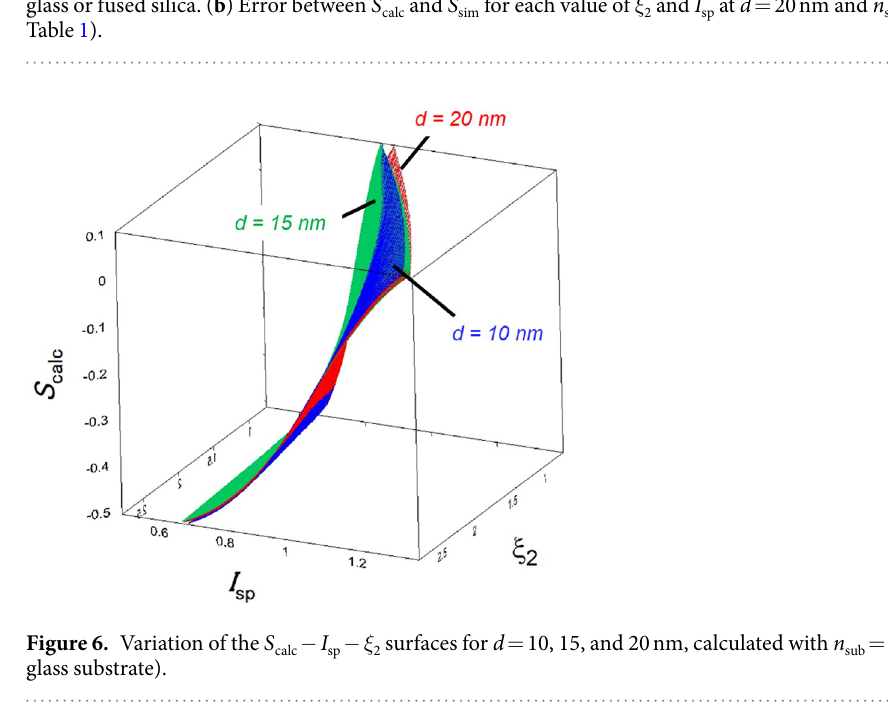
(DACT-II):CBP. Table 2 summarizes the S calc and reported S values. Even for the largest error, the differences between the calculated and simulated values were less than 0.05, and in good agreement with our estimation (Fig. 5b). While the dipole orientation of a guest emitter doped in a host matrix has been evaluated by a combination of angular dependent PL measurements with optical simulation analysis, we developed the method to directly analyse a radiation pattern obtained in angular dependent PL measurements without the use of any optical sim- ulations. The parameters used to evaluate the dipole orientation were a , a ′ , a ″ , a ″′ , k , k ′ , k ″ , k ″′ , c , c ′ , c ″ , c ″′ , e , e ′ , e ″ , and e ″ , which were determined by d and the substrate type. For practical use of this method, we have listed parameters for typical glass and fused silica substrates with a range of d values from 10 to 20 nm. The consid- ered range of d is sufficiently small to be able to neglect the effects of λ in the visible range (400–700 nm), hence one can use this method without considering λ . For practical applications, a radiation pattern should be meas- ured and the value of n org determined. When we applied this calculation method to estimate S calc for previously reported results from TADF emitters, the resultant S calc values reproduced the reported values well with an error of less than 0.05. The error was consistent with our estimated error, which was evaluated by a comparison of S calc